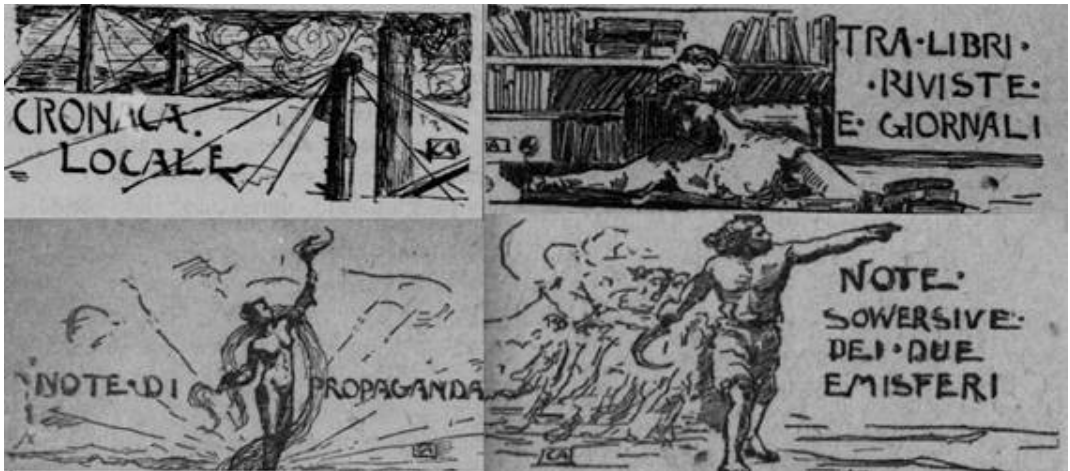
Figure 2 Artwork marking the beginning of regular Cronaca Sovversiva